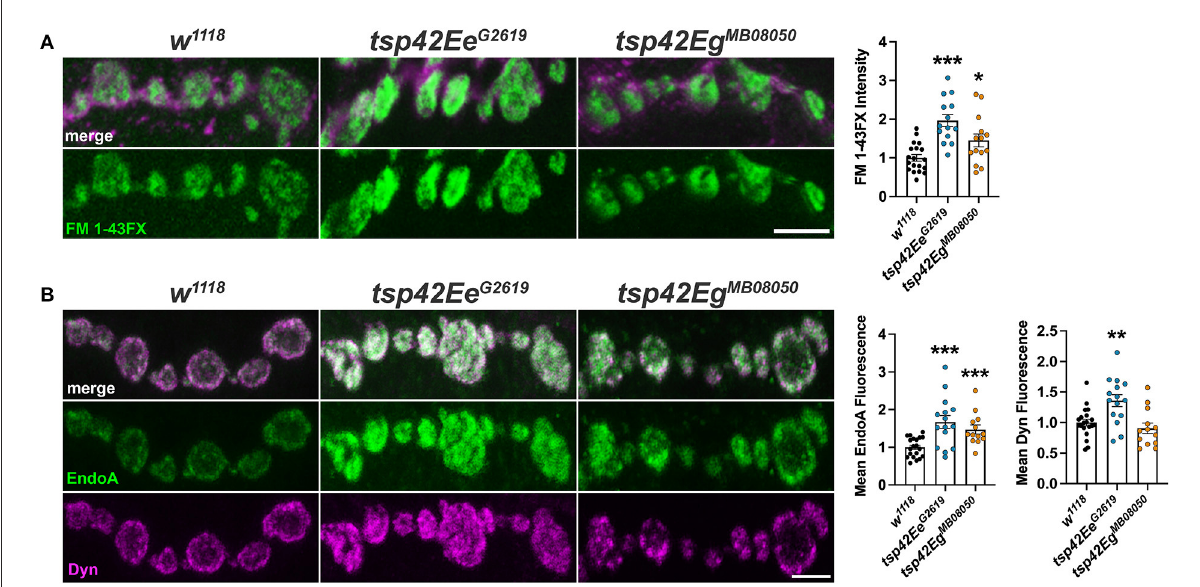
FIGURE4 Tsps negatively regulate endocytosis and endocytic protein localization. (A) Representative confocal images showing relative rates of endocytosis in HL-3 + 1.0mM Ca 2 + as measured by FM 1-43FX immunofluorescence at 6/7 terminal boutons (left). Quantification of FM 1-43FX fluorescence intensity relative to w 1118 controls (right). Both tsp42Ee G 2619 and tsp42Eg MB 08050 mutants show significantly higher endocytosis ( p < 0.0001 and p = 0.0144, respectively). (B) Representative images of terminal boutons (left) immunolabeled for EndoA (green) and Dyn (magenta) and quantification of mean immunofluorescence (right). EndoA fluorescence is significantly increased in both tsp42Ee G 2619 ( p = 0.0002) and tsp42Eg MB 08050 mutants ( p = 0.0004). Mean Dyn fluorescence is significantly increased in tsp42Ee G 2619 mutants ( p = 0.0018). Scale bars = 5 µ M. Errors bars represent SEM. Unpaired t tests were used for all statistical